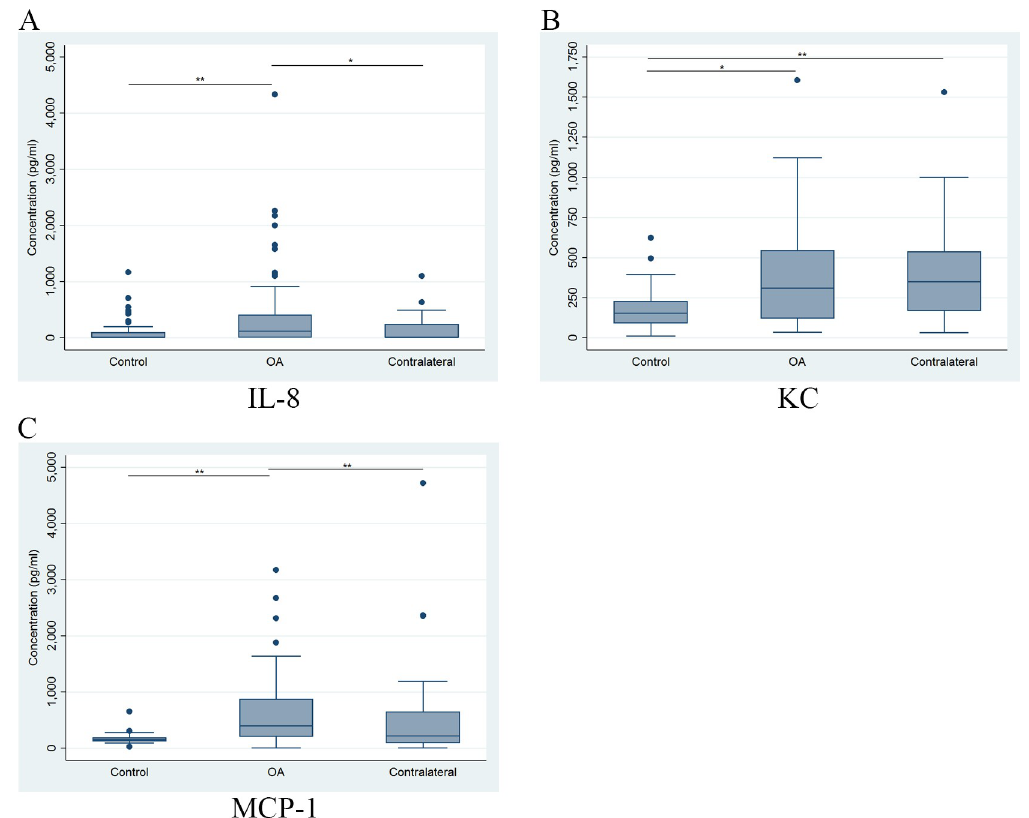
Fig 2. Comparison of synovial fluid biomarkers (IL-8, KC and MCP-1) between control and OA group samples. Comparison of the distribution of IL-8 (A), KC (B), and MCP-1 (C) synovial fluid concentrations (pg/ml) at the initial visit (T1) for stifles with OA (OA), the stable stifles in the OA dogs (contralateral) and control dogs (control). The horizontal line inside each box is the median and the upper and lower edges of box present the inter-quartile range (IQR). The whiskers are either 1.5 × IQR or the range, whichever is smaller. Dots outside the fence are outliers. � Statistically significant if P < 0.05, �� or if P < 0.01. index stifle and control stifles for all three biomarkers (Fig 2). IL-8 and MCP-1 levels were sig- nificantly different between the index and contralateral stifles, while KC levels in the contralat- eral stifle were significantly different from the control but not the index stifle samples (Fig 2). A summary of comparisons between concentrations of the three SF biomarkers among con- trols, the index OA stifles and contralateral stifles at all three time points are presented in Table 3. Based on these results, there were significant differences between T1 and T2 for SF concentration of all three biomarkers between the index stifle and control samples. There were significant differences between SF concentrations of index and contralateral stifles in the OA group for IL-8 at T1 and T2 and for MCP-1 at all three time points. However, the only differ- ences observed between control versus contralateral stifles was for KC concentrations at all three time points. Comparisons of SF biomarker concentrations at different time points in either index or contralateral stifles in the OA group are shown in Fig 3. For the OA stifles, there was a signifi- cant decrease in all three biomarker concentrations at T3 compared to T1 and T2. However, there was no significant difference in biomarker concentrations between T1 and T2 despite a trend for elevation in all three biomarkers in the OA stifles. The results showed no significant change over time in the contralateral stifles (Fig 3).